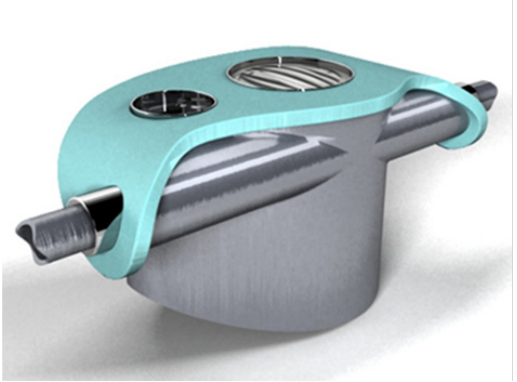
Fig. 4. It's a new product called "Hydral" by “A